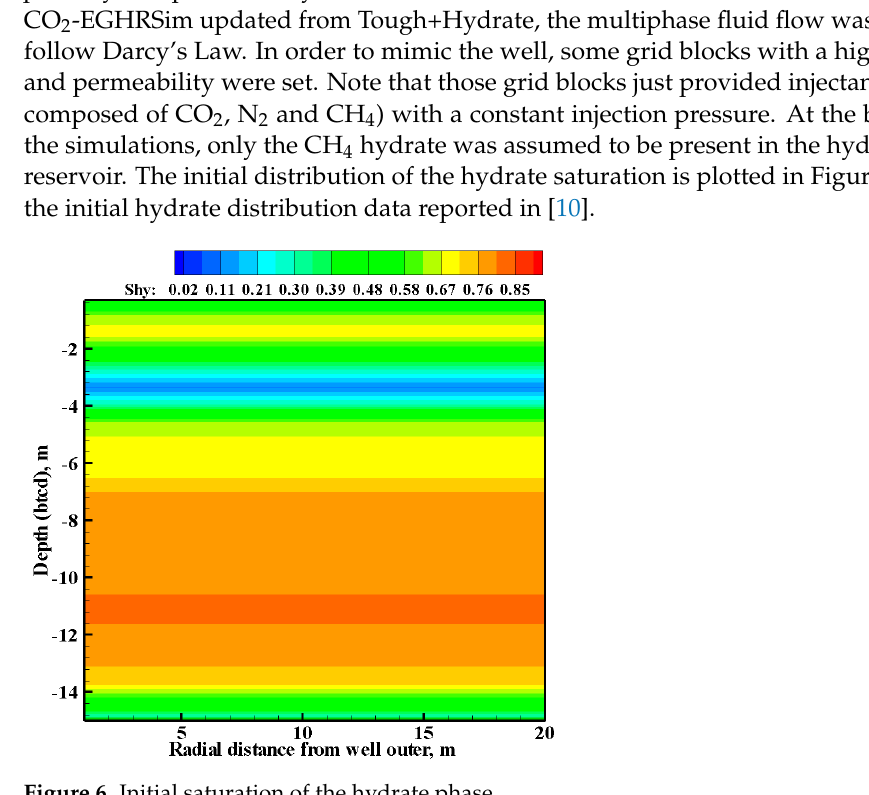
Figure 7. Measured and simulated Cumulative CO 2 and N 2 during the injection.